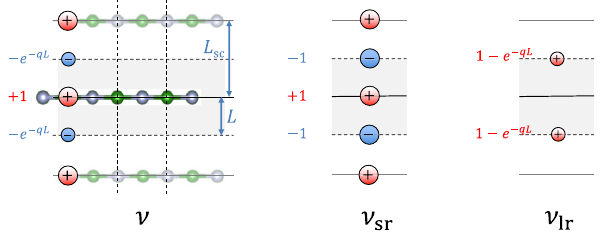
FIG. 8. Interpretation of the Coulomb truncation technique as an image-charge method and its separation into long-range and short-range contributions. The shaded areas refer to the region of space where the three kernels exactly match those illustrated in Fig.